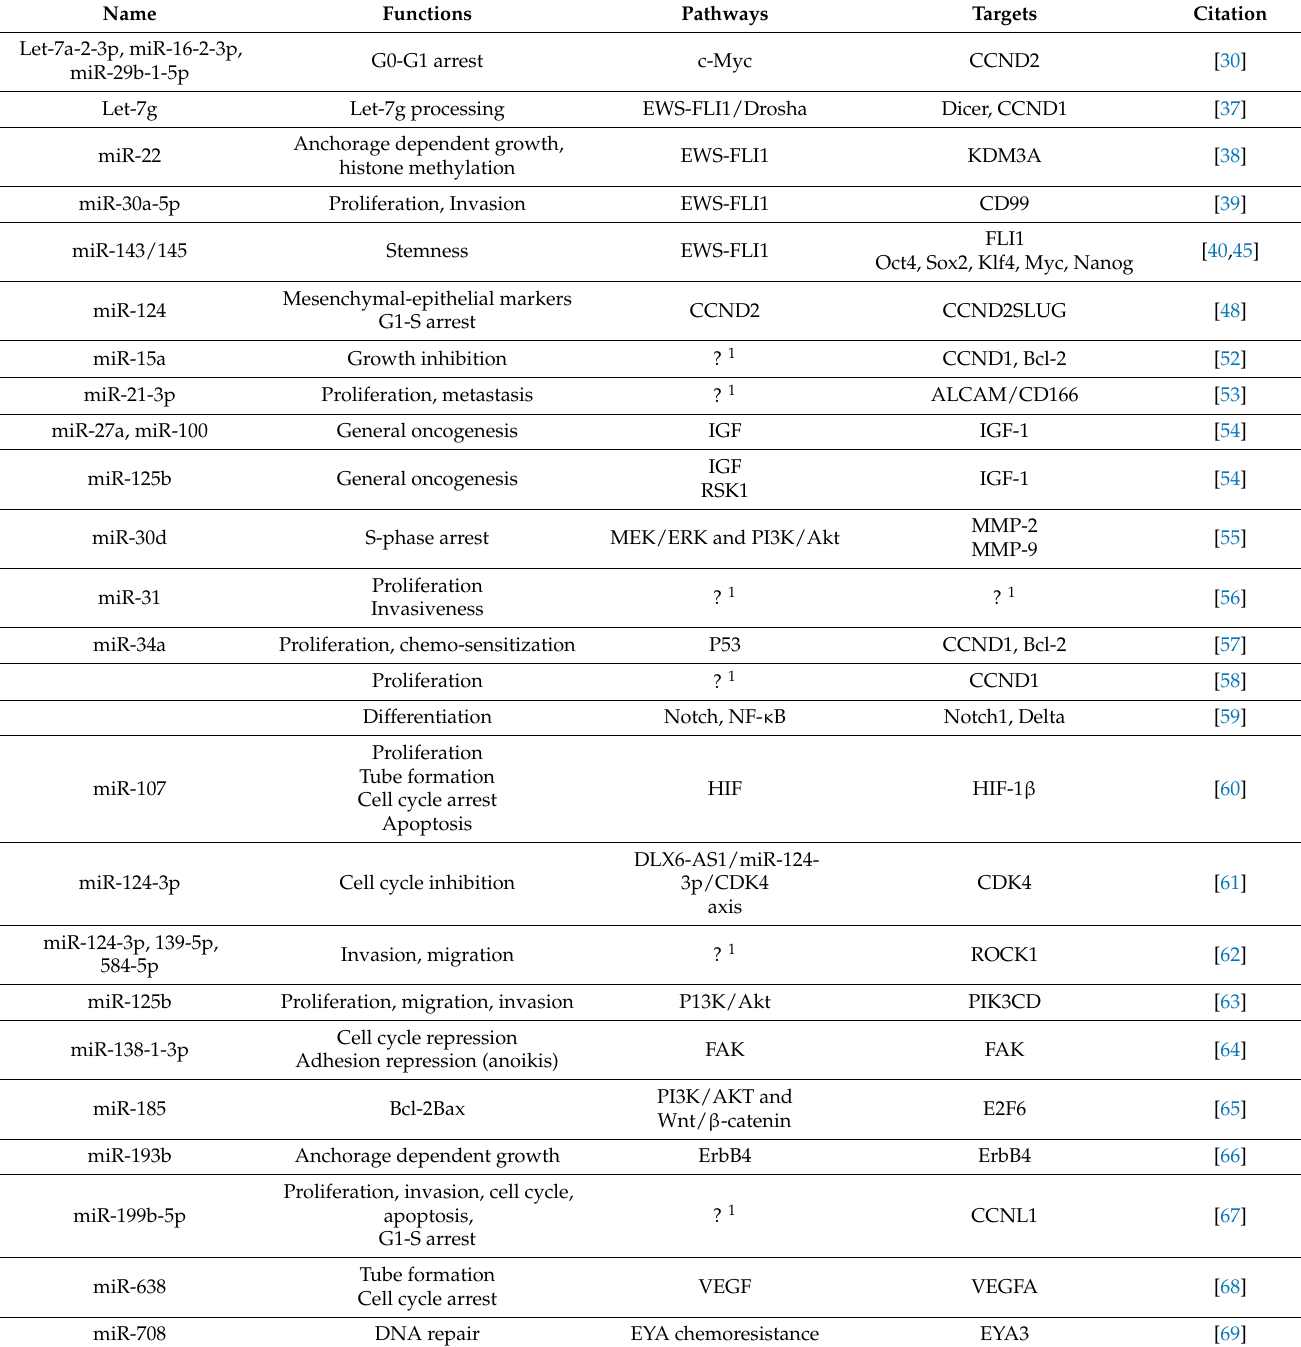
Table 1. MicroRNA in Ewing’s Sarcoma with Tumor Suppressor